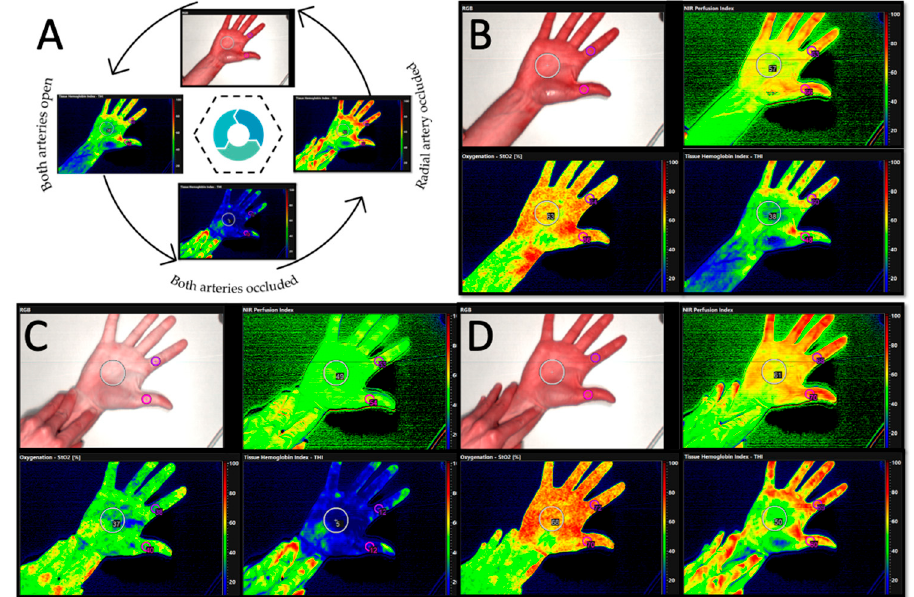
Figure 2. ( A ) Course of the experiment. First, a baseline measurement was taken (time point I, both arteries open), then both, the radial and the ulnar artery were occluded (time point II) and at time point III, the ulnar artery was released. Hyperspectral images were taken at all three time points throughout the course of the experiment as part of the hyperspectral accompanied MAT. In ( B ) the baseline measurement is displayed showing the NIR perfusion index, oxygenation and tissue hemoglobin index. Three circular shaped regions of interest (ROI) were manually positioned. ( C ) After occlusion of the ulnar and radial artery, the hand obviously turns pale. The values for NIR perfusion index decrease from 57 to 49 in the middle of the palm indicated by a less red and more green color of the hand. The same applies for the tissue oxygenation showing many red spots before occlusion and a green and blue color after occlusion of the vessels (StO 2 decrease from 63% to 37%). Changes in THI are most obvious indicated by a color change from green to dark blue (THI decrease from 38 to 5). ( D ) shows the measurements after release of the ulnar artery in a healthy participant. The return to perfusion is indicated by the red and green colors in all pictures. After reperfusion, there is a slight hyperemia of the hand, which is evidenced by the increase in the measured values (NIR1: 57 and NIR3:61; StO 2 1: 63% and StO 2 3: 68%; THI1: 38 and THI3:50).